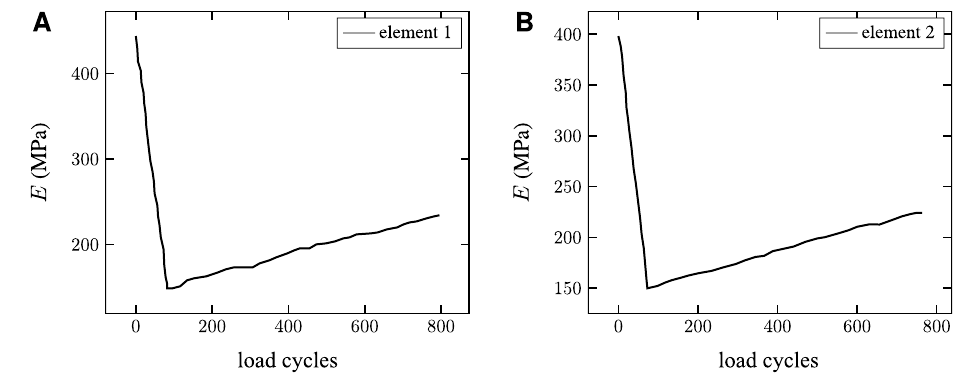
Fig. 11. Evolution of Young’s modulus for element 1 (A) and element 2 (B) along the load cycles - initial